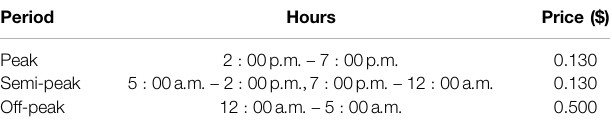
TABLE 2 | The time block division for TOU pricing. Period